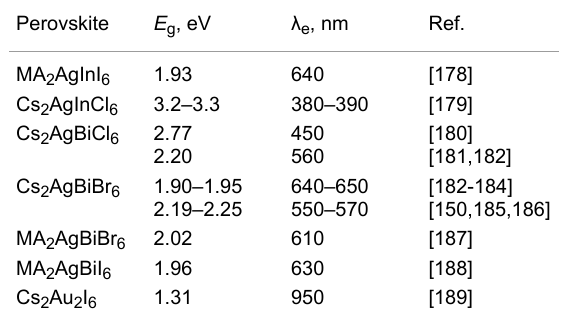
A 2 AgBiX 6 , A 2 AgSbX 6 , and A 2 AgInX 6 (A = MA or Cs, X = Cl, Br) was reported. The bandgaps of selected A + /A 3+ - HPs are presented in Table 4. Table 4: Bandgap and approximate absorption band edge position ( λ e ) of selected A + /A 3+ -based HPs. Perovskite E g , eV λ e , nm Ref.